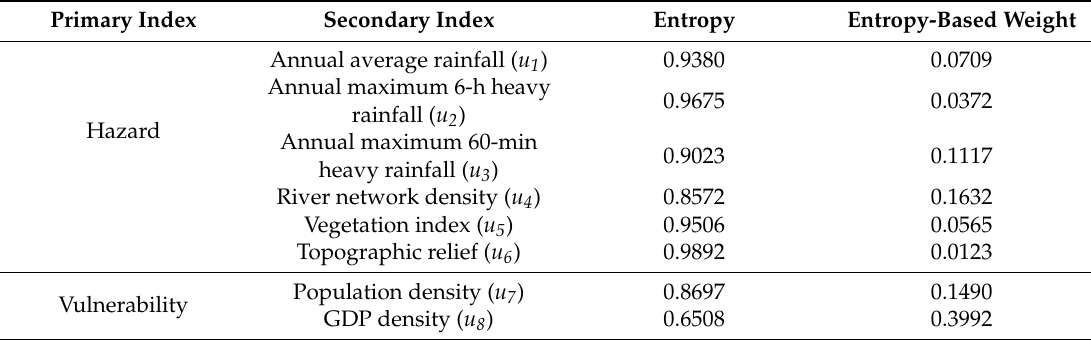
Table 9. Entropy and entropy-based weight of each index for risk assessment of mountain torrent disaster.